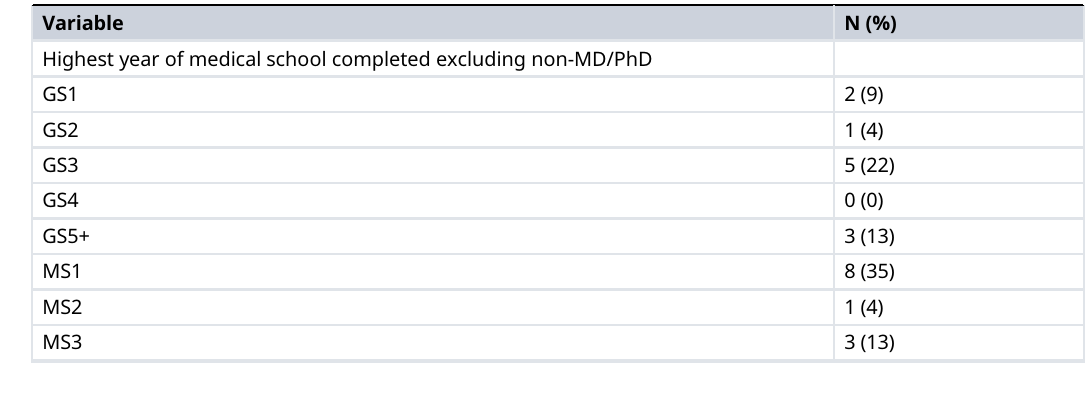
Table 2. COVID-19 restrictions reported by medical students during the COVID-19 pandemic. Variable N (%) Are there currently restrictions in the place where you live? There is a stay-at-home order given by state or local authorities. 2 (2) Social isolation is recommended by state or local authorities. 46